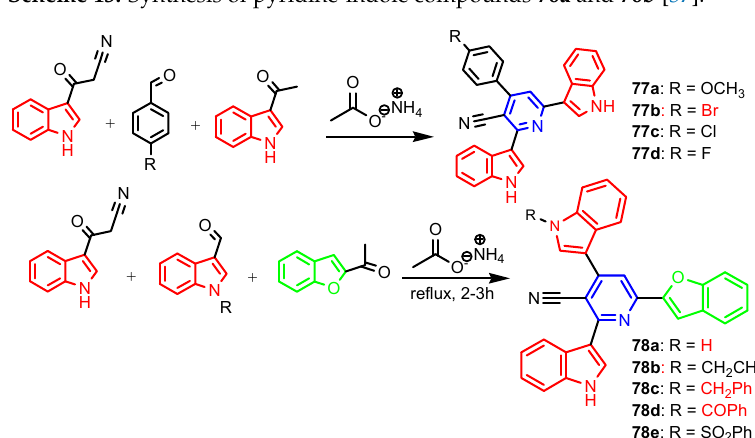
Scheme 14. Synthesis of bis(indolyl)pyridines 77a–77d and 78a–78e Table 3. Minimum inhibitory concentrations (MIC, µg mL − 1 ) and minimum bactericidal concentra- tions (MBC, µg mL − 1 ) of the most active bis(indolyl)pyridines [38].